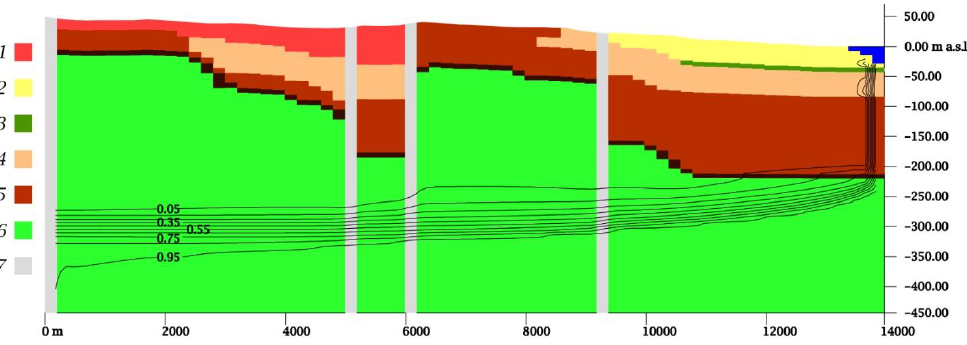
Fig. 9. Representative vertical section correspondent to the line (a–a) for the scenario without pumping. 1: “Calcarenite di Gravina”; 2: “Sabbie di Uggiano”; 3: subappennine clays, 4: “Calcereniti di Andrano”; 5:”Pietra Leccese”; 6: “Altamura” limestones; 7: “faults”. The colors reflect the lithostratigraphical reconstruction shown in Fig. 1.